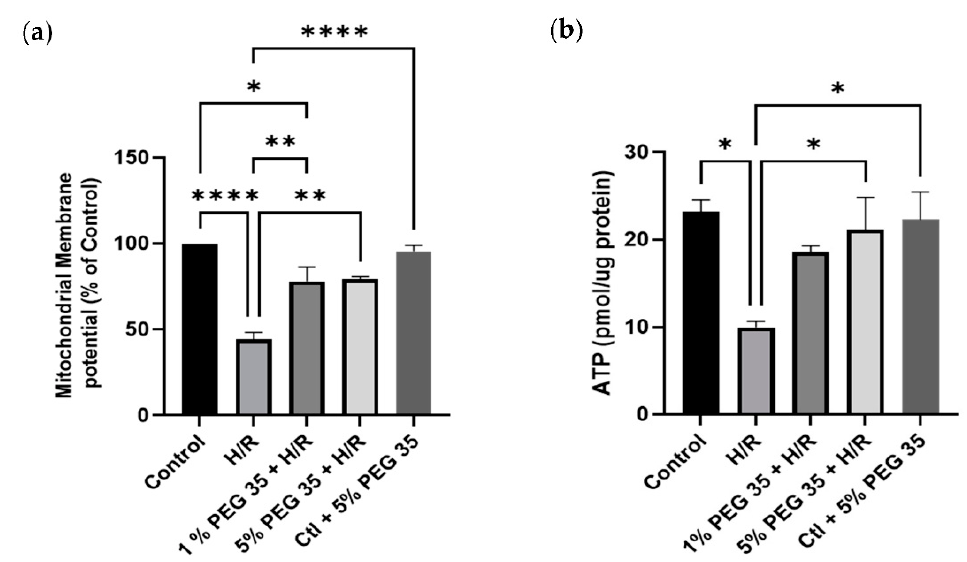
Figure 3. PEG35 effects on mitochondrial function. ( a ) Mitochondrial membrane potential ( ∆Ψ ) was assessed using TMRM, as described in the Materials and Methods section. ( b ) ATP content in HepG2 cells. The values shown represent the mean ± SEM of 3 independent experiments. * p < 0.05; ** p < 0.01; **** p < 0.0001.